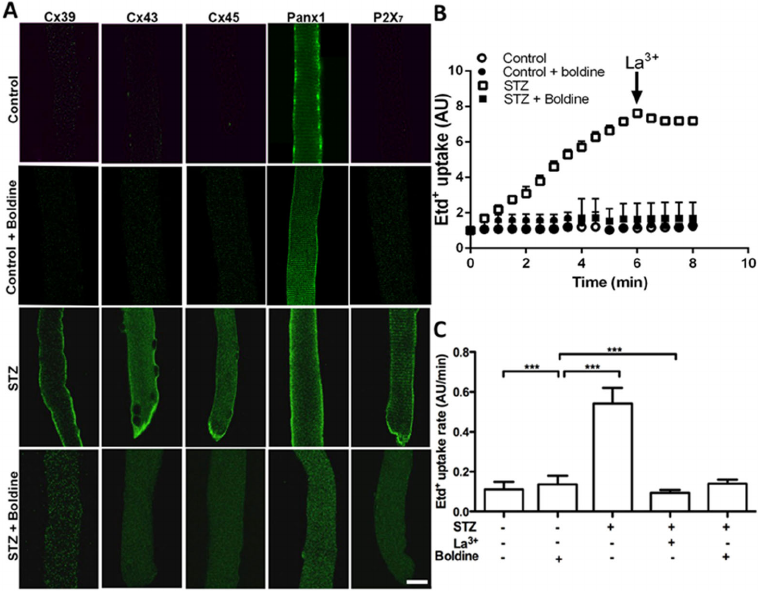
Figure 3. Boldine reverts the sarcolemma permeabilization of freshly isolated skeletal myo fi bers from diabetic rats. ( A ) Immuno fl uorescence against Cx39, Cx43, Cx45, P2X 7 , and Panx1 proteins was evaluated in freshly isolated skeletal myo fi bers from control and diabetic (STZ) rats treated or not with boldine (scale bar: 20 µm). ( B ) Time lapse of ethidium (Etd + ) uptake assay in myo fi bers of fl exor digitorum brevis muscles from control (circles), control + boldine (black circles), diabetic (STZ, squares) and diabetic animals treated with boldine (50 mg/kg) for 3 weeks (STZ + boldine, triangles). ( C ) Quanti fi cation of Etd + uptake rate (slopes of curves like in ( A ). In some experiments, the acute e ff ect of 150 mM La 3+ on the uptake rate of myo fi bers from control and diabetic animals was evaluated. *** p < 0.001. (N = 5 animals per group and from each animal 10 myofibers were analyzed).